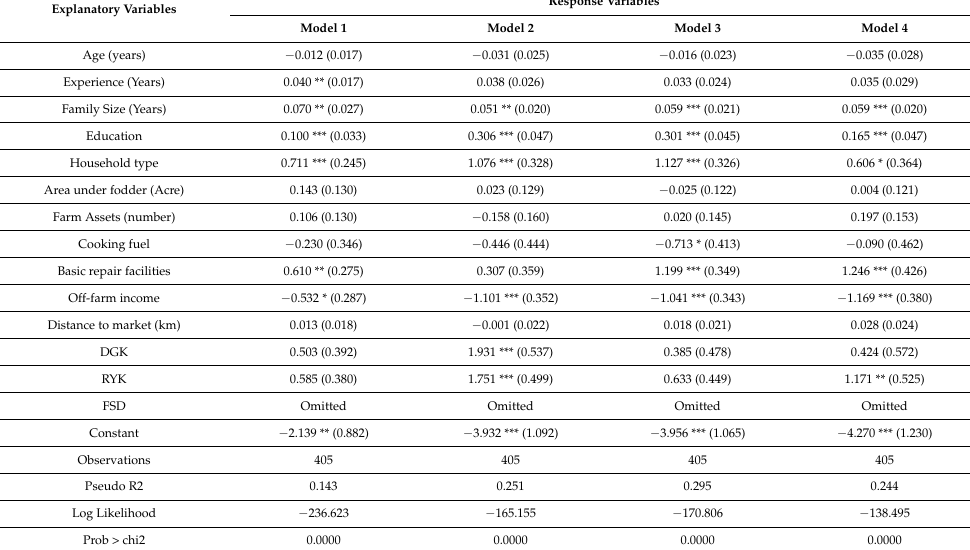
Table 7. Drivers influencing livestock herders’ adaptations to climate